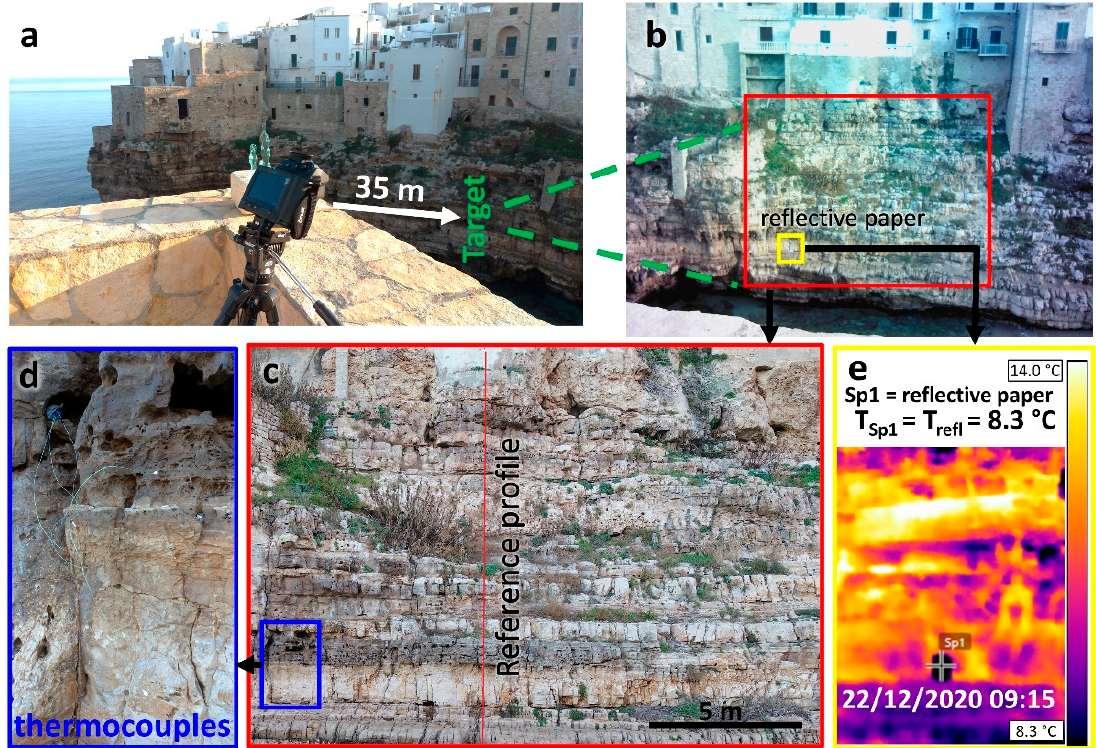
Figure 5. Setup of the IRT acquisition. ( a ) Location of the FLIR T-660 thermal camera and perspective view of the target; ( b ) frontal view of the target area and position of the reflective paper (yellow square); ( c ) zoom of the investigated area and scanline for the extraction of the thermal and lithologic profile; ( d ) location of the thermocouples for the temperature monitoring of the lithofacies; ( e ) example of measurement of the reflected temperature using the reflector method.